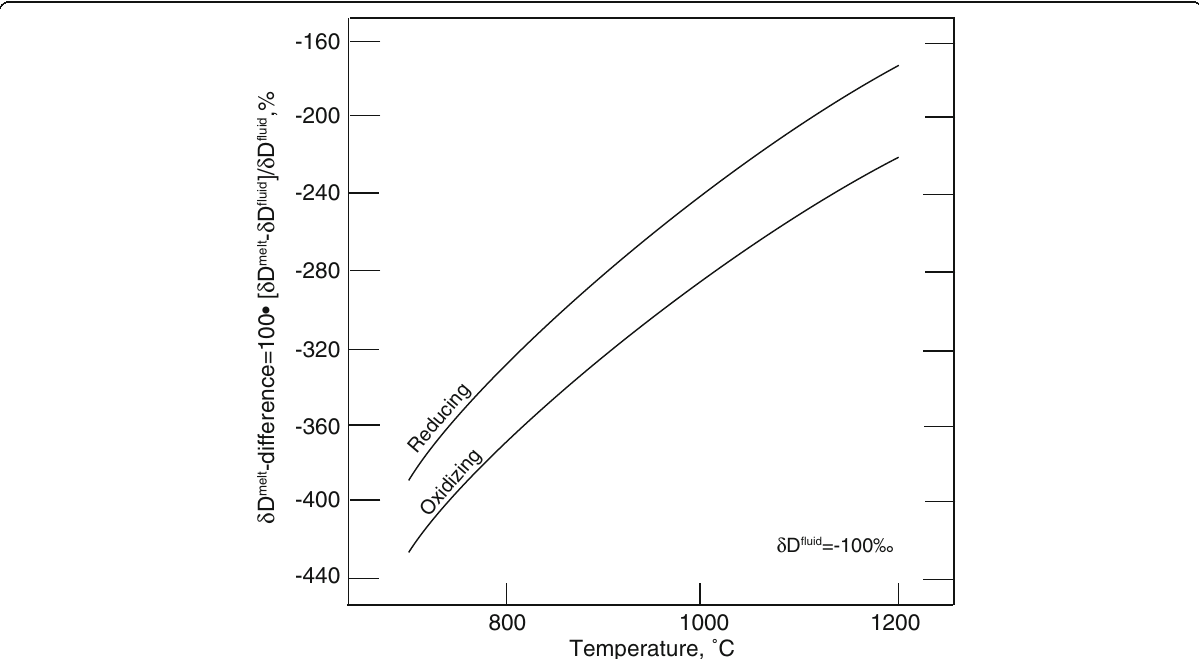
Fig. 8 Evolution of D/H difference between coexisting melt and fluid wit7h constant δ D of the fluid at 100 ‰ as a function of temperature in silicate – COH systems under reducing and oxidizing